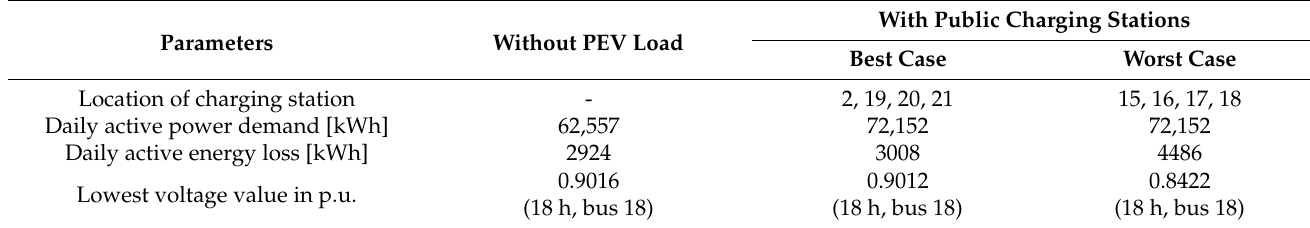
Table 4. Best and worst cases for EVCSs